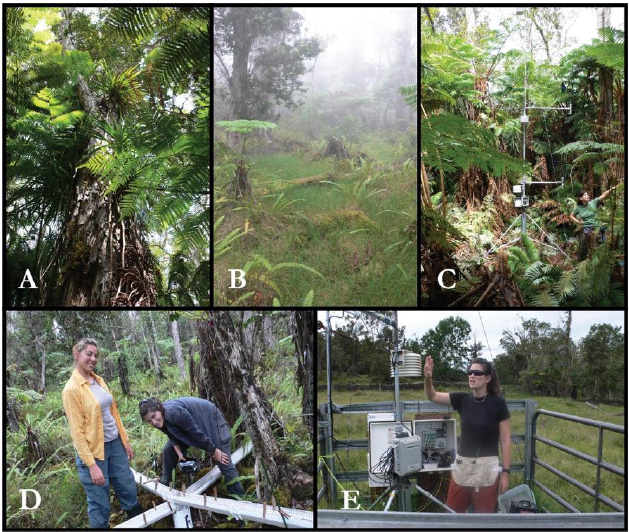
Figure 3. Taking micrometeorological measurements of water fluxes in native forest and pasture in Kona, on the west side of Hawai‘i Island, to measure groundwater recharge, the sole source of water for the coastal community [52–54]. ( A ) Large, complex, and multi-layered leaves within Kahalu’u Forest have high surface area that intercepts fog and contributes to groundwater recharge; ( B ) Fog interception by leaves is somewhat lower in this more open forest; ( C ) Kate Brauman setting up a micrometeorological station in forest; ( D ) Kate Brauman and Heather Tallis setting up devices for measuring the amount of precipitation that falls through the forest to the ground (as opposed to evaporating from leaf surfaces; ( E ) Kate Brauman taking meteorological measurements on Palani Ranch ( PC: Gretchen C. Daily, A – E